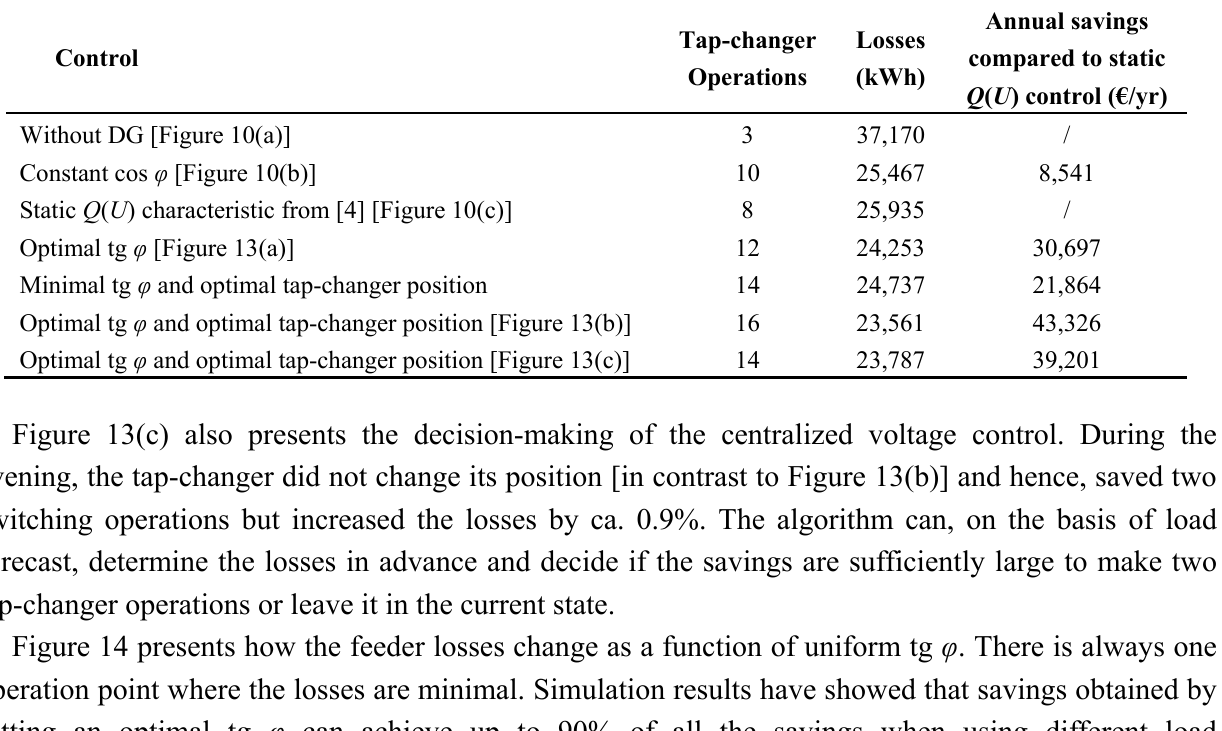
Table 1. Simulation results for loads with constant power